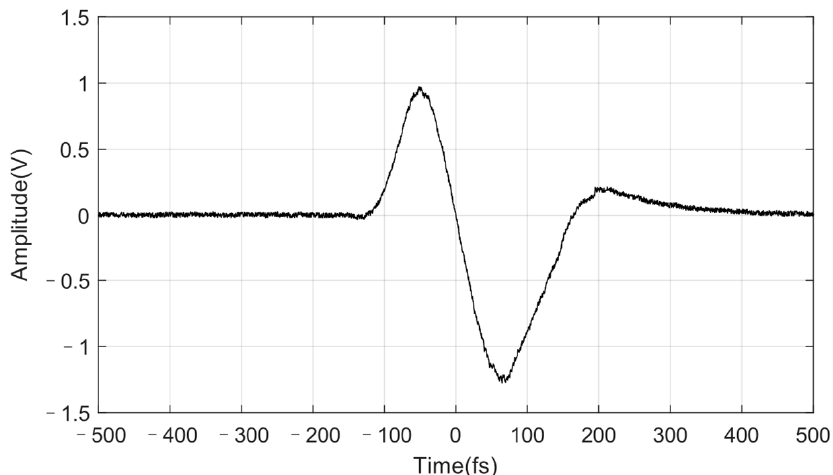
Figure 5. Discrimination signal produced in one unit. The time axis is scaled by Δ f r /f r after the signal is measured by an oscilloscope.